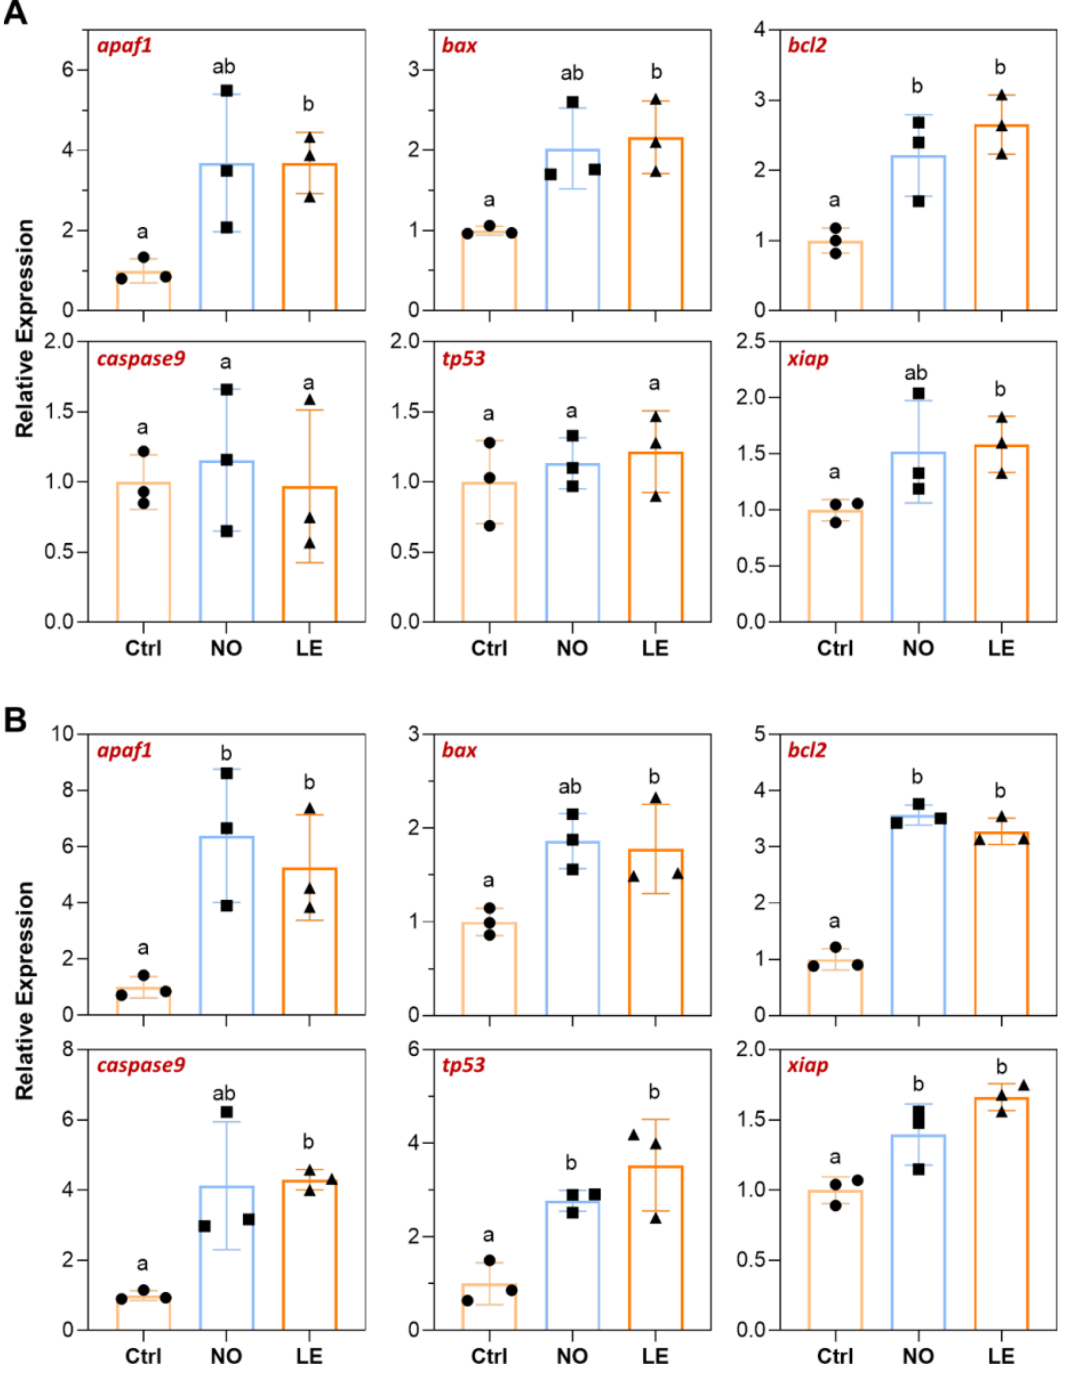
Figure 6. Expression of apoptosis-related genes determined by qPCR. ( A ) Brain. ( B ) Liver. The error bars represent SD ( n = 3). The dots, squares and triangles represent data of the corresponding experimental groups shown in the horizontal axis. Different letters above the error bars indicate significant difference between the means ( p ≤ 0.05).